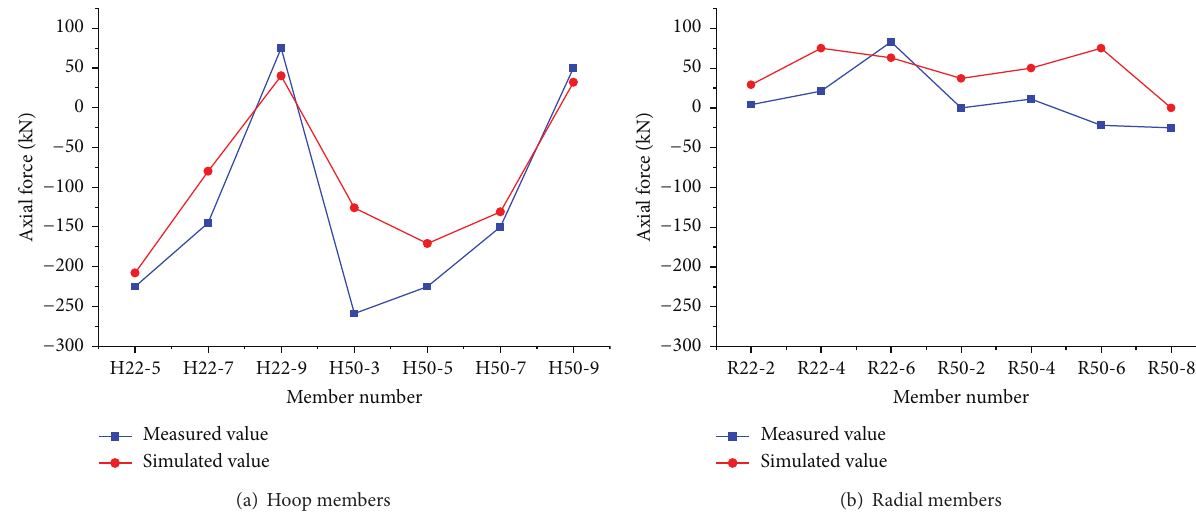
Figure 23: Force increment of the members in the 70%–110%